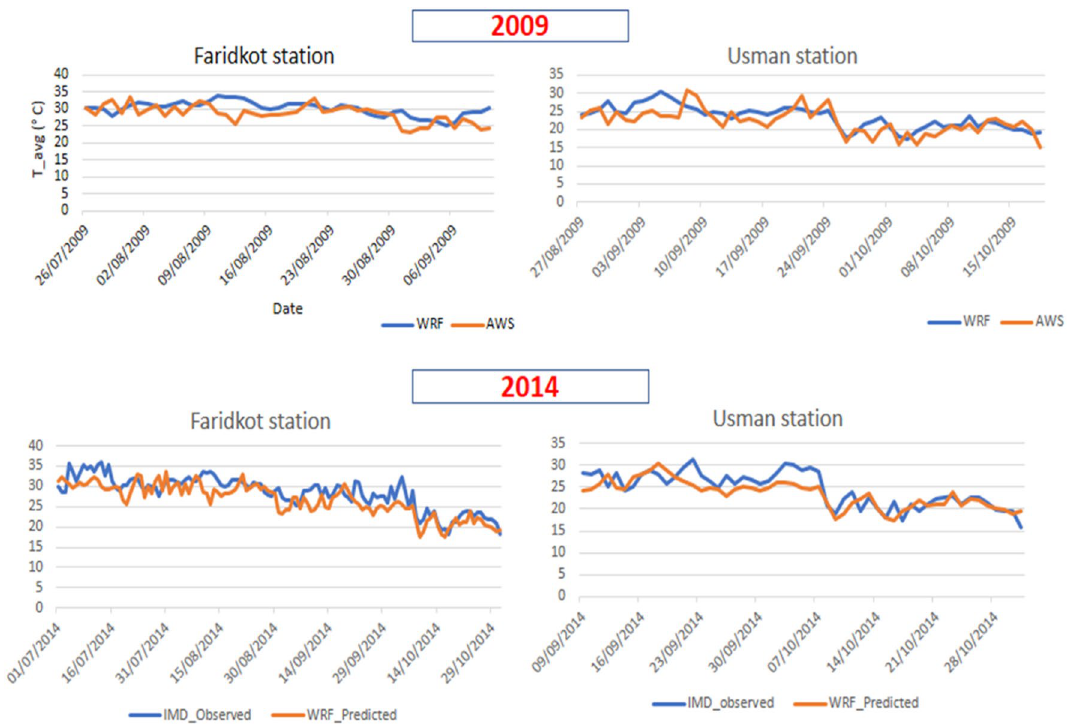
Figure 8. Simulated and observed mean daily temperature (°C) timeseries obtained from the WRF model and ISRO, respectively, at the Faridkot and Usman hydrometeorological stations during 2009 and